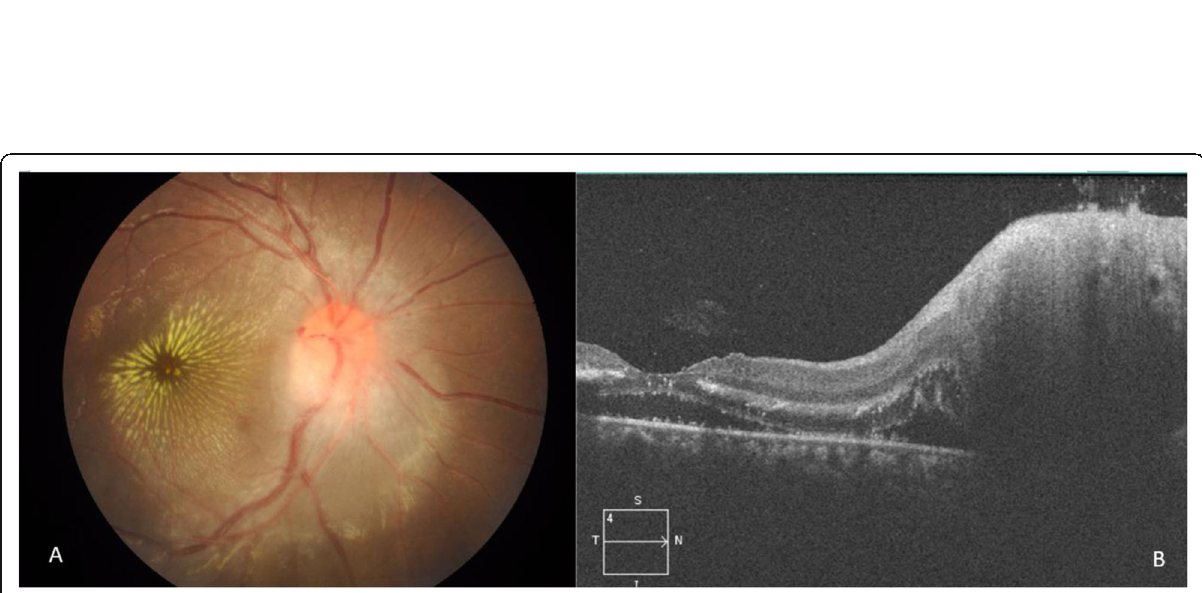
Fig. 1 Patient no. 5. a , b and c Colour fundus photograph of the right eye: multiple small foci of yellow-white retinitis lesions. The lesions ’ borders become more well-defined and the sizes reduce over time. d SD-OCT of the same eye: cross section superior to the fovea across the foci of retinitis appear as hyperreflectivity in the inner retinal layers while casting a shadow below it